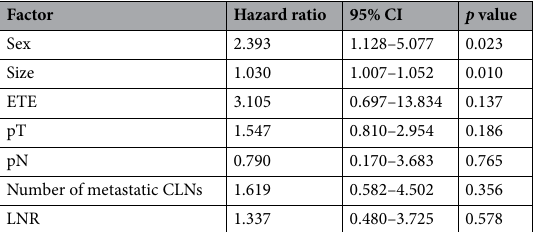
Table 2. Logistic regression analysis for disease recurrence adjusted for clinico-pathologic factors. CI confidence interval, ETE extrathyroidal extension, LN lymph node, LNR lymph node